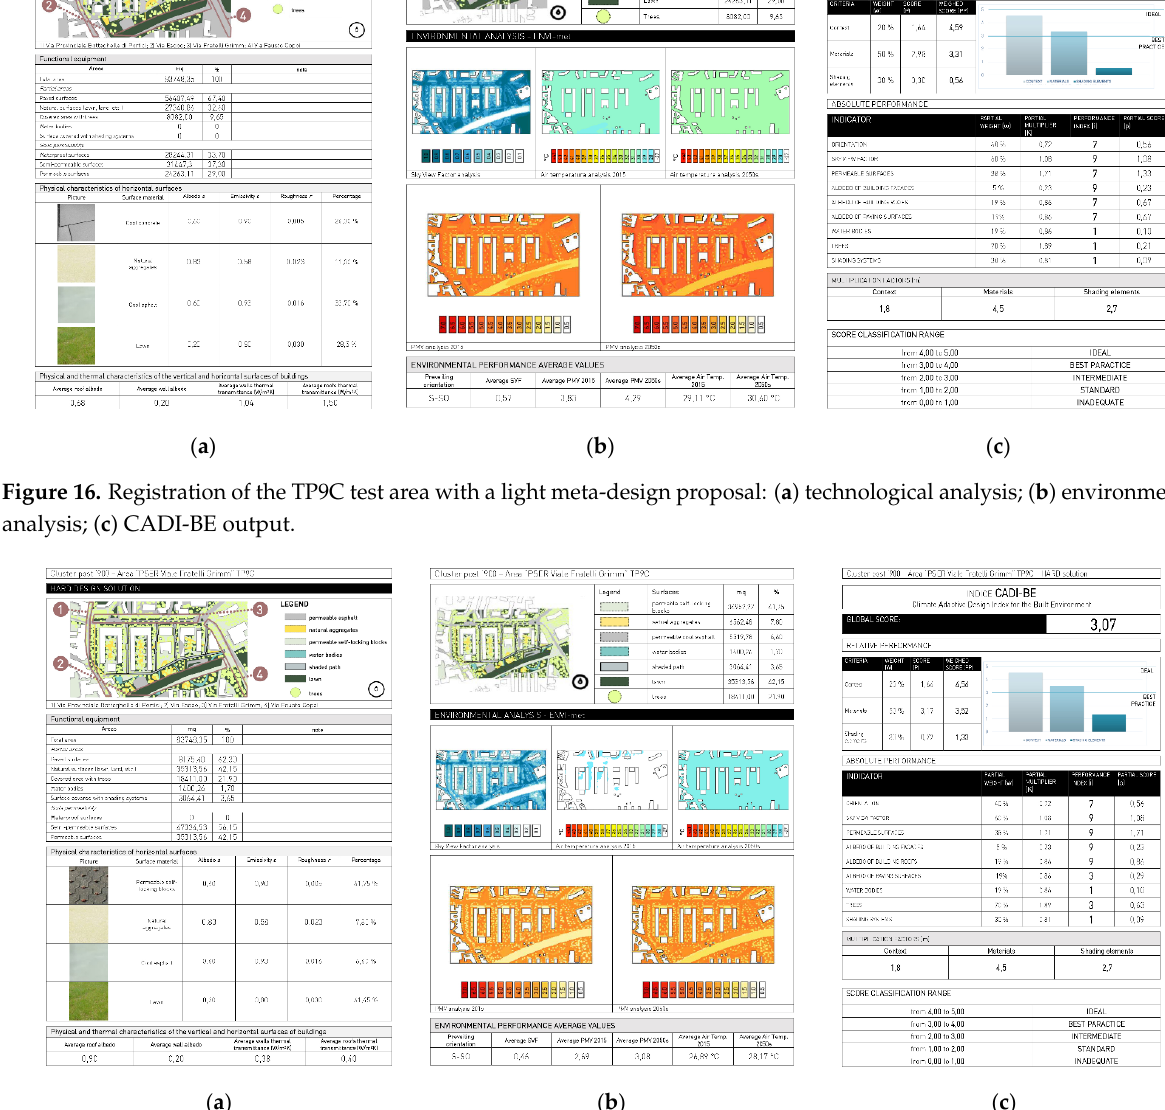
Figure 17. Registration of the TP9C test area with a hard meta-design proposal: ( a ) technological analysis; ( b ) environmental analysis; ( c ) CADI-BE output. Table 4. Comparison of PMV average values: absolute reduction and